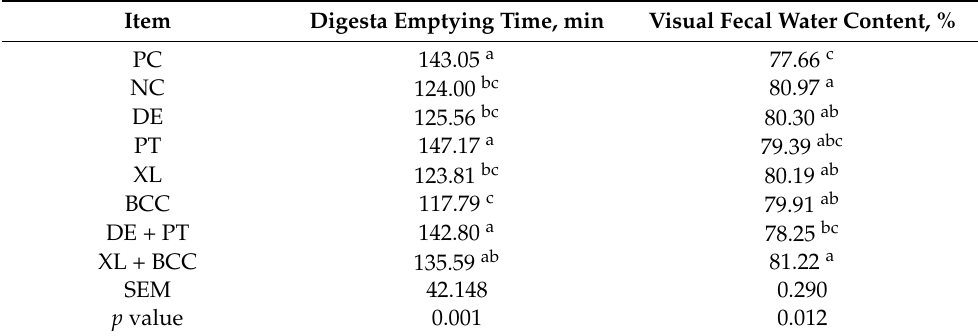
Table 5. Supplemental enzymes with probiotics on digesta emptying time and visual fecal water